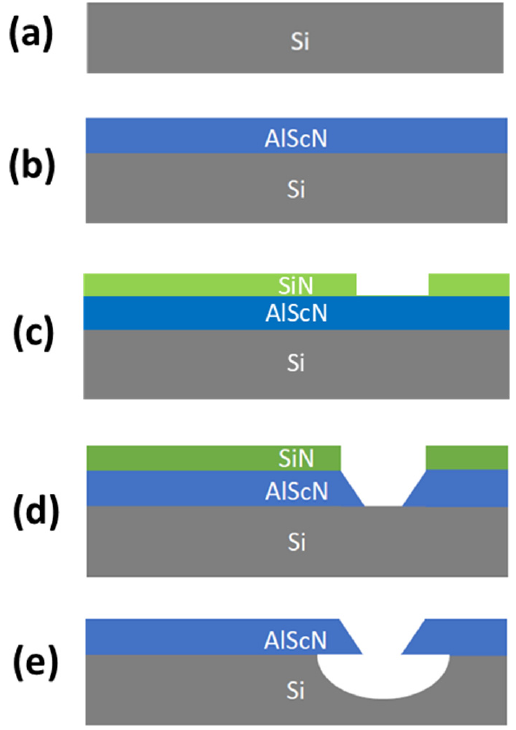
Figure 1. Fabrication process for realizing Al 1 − x Sc x N cantilevers with ( a ) p-type (100) Si wafer ( b ) Al 1 − x Sc x N deposition using Evatec CLUSTERLINE ® 200 II PVD system ( c ) PECVD SiN deposition and patterning using CF 4 RIE ( d ) KOH in 45% H 2 O etch of Al 1 − x Sc x N ( e ) SiN hard mask stripped using CF 4 RIE and Al 1 − x Sc x N cantilevers released using isotropic XeF 2 dry etching.